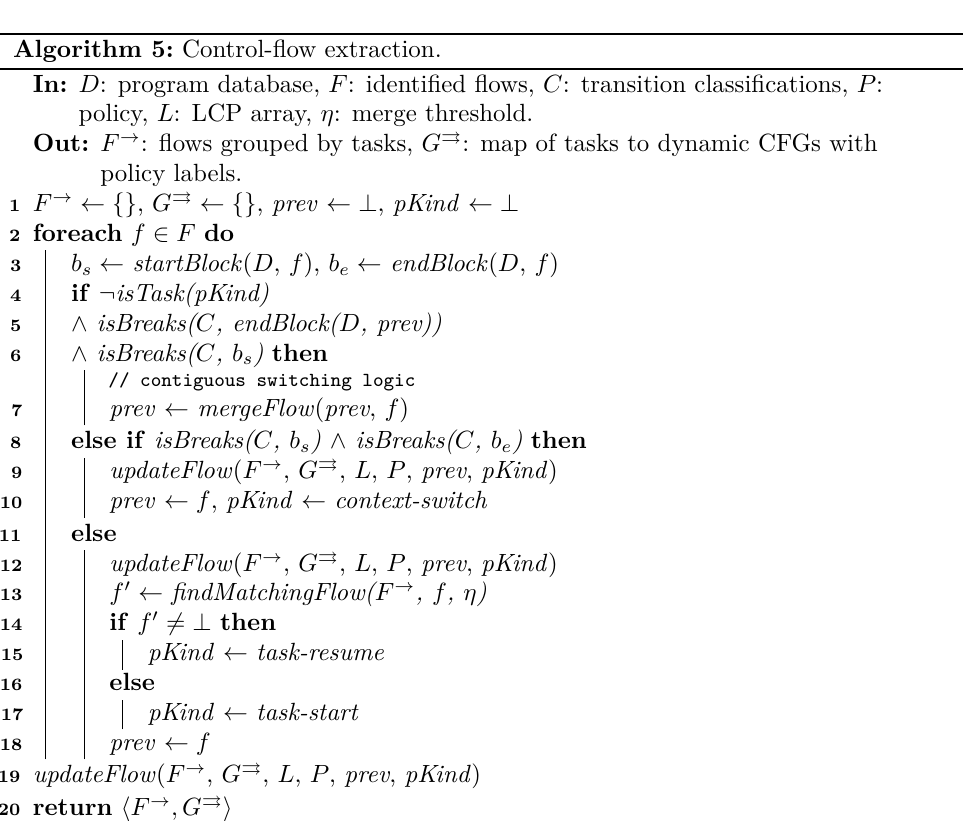
Algorithm 5: Control-flow